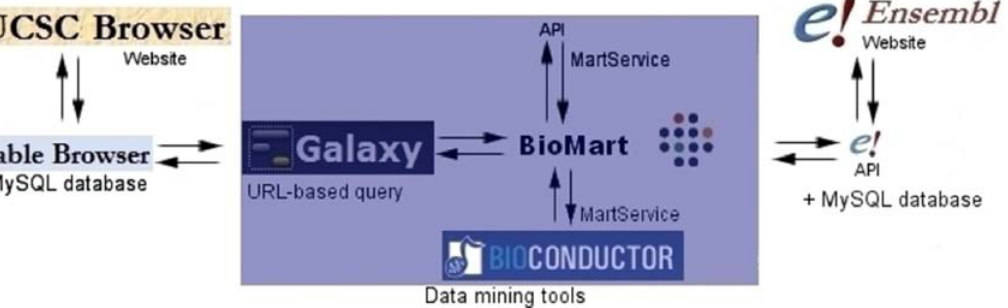
Figure 1. Diagram depicting the way different applications interact with data mining tools. The boxed area shows the topics discussed in this paper. BioMart’s Central Server coordinates access to different databases: on the left-hand side, Galaxy interacts with BioMart by means of URL- based queries, allowing interaction with the UCSC Genome Browser and its Table Browser; while on the right interaction with Ensembl and its API is shown. Other platforms such as BioConductor rely on Web services ( MartService ) to retrieve information from the BioMart system. Additionally, BioMart is compliant with the DAS protocol [34] and can be queried by means of a Perl API, biomart-perl , as well as a Java API, martj .